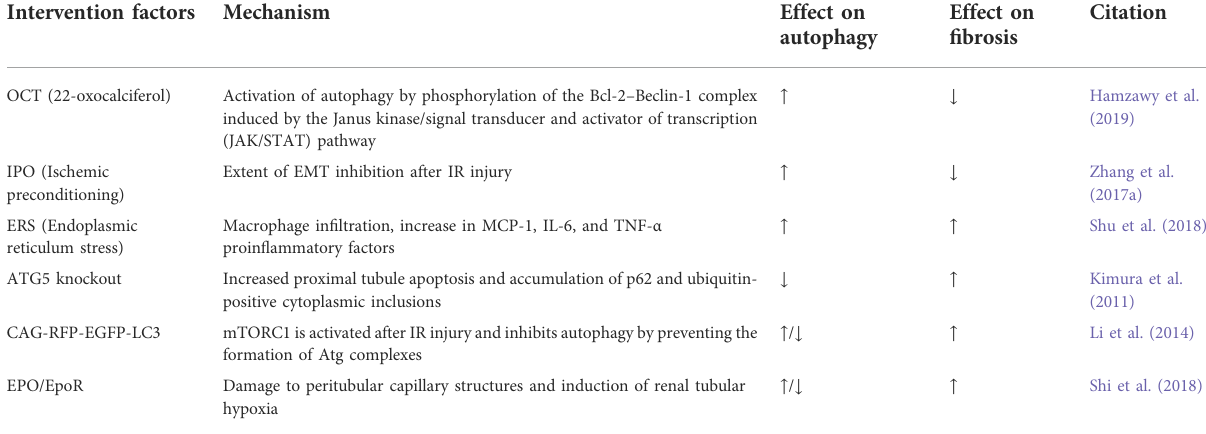
TABLE 1 Dual regulation of autophagy in ischemia-reperfusion injury